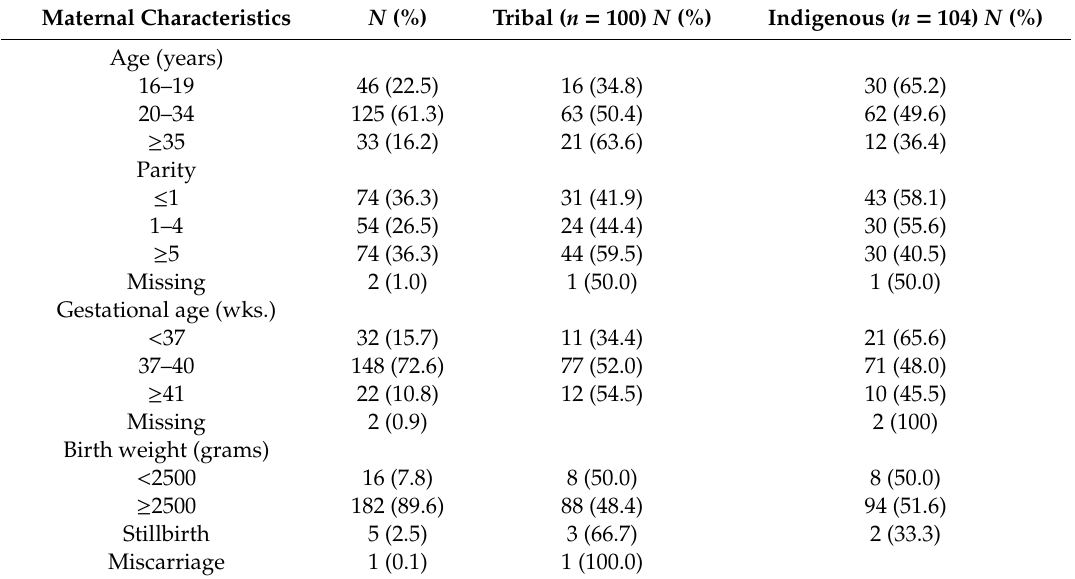
Table 1. Characteristics of 204 participants.